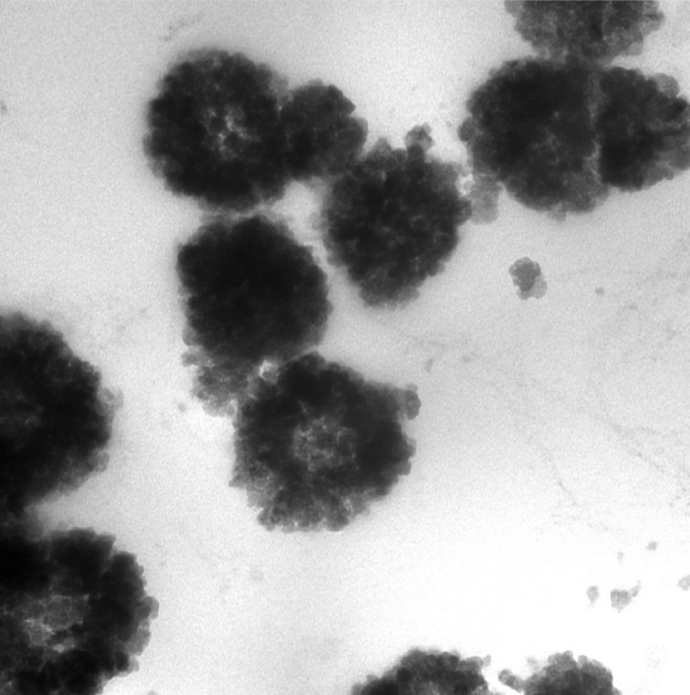
Figure 3. TEM images of Tyr-MB embedded into Spurr’s epoxy resin, which show the distinction between the hydrophilic outside layer and the magnetic iron oxide cluster solid core on the inside. The iron oxide cluster is displayed as light gray inside of each MB. The black color surrounding the light gray iron oxide cluster core is the hydrophilic outside layer, which is where Tyr binds. Direct magnification of 200,000 × . The magnetic beads have an average diameter of 168.2 ± 24.4